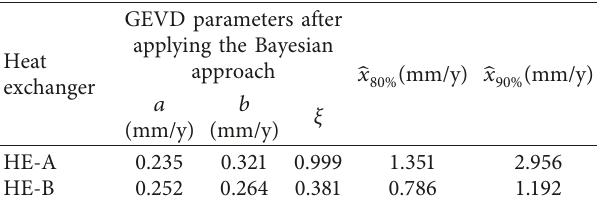
Figure 5: Wall thickness in HE-B in 2000 (a) and wall thickness thinning rate in HE-B in 2000 (b) (all the Probability Density Function (PDF) values plotted in this paper were adjusted in order for the distribution to “look like” the histogram. To do this, it is necessary to convert the PDF to the histogram’s size using the bins’ width and the number of bins. Reference [44] explains this process in detail). Table 2: GEVD parameters of the distributions obtained after the Bayesian approach in heat exchangers HE-A and